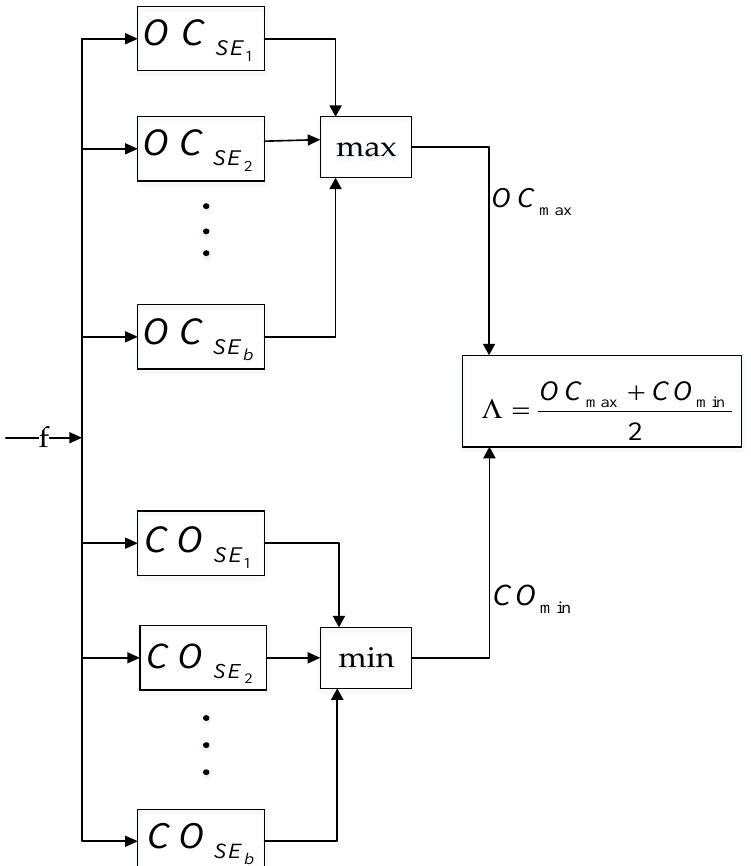
Figure 19. Process flow of opening closing ( OC ) max—closing opening ( CO ) min filter.